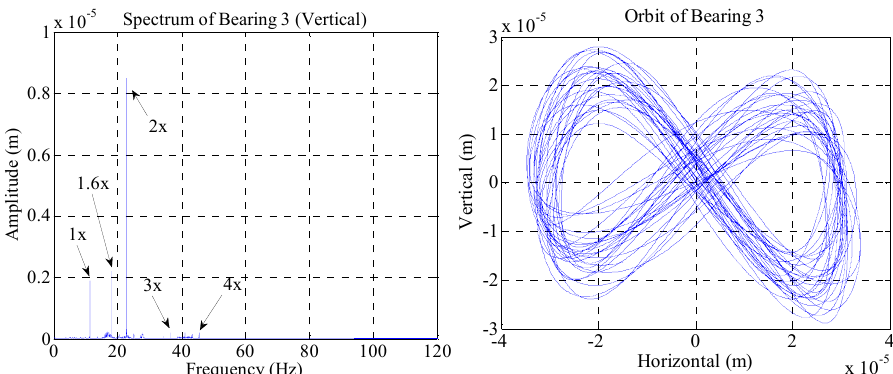
Figure 20. The spectrum and the orbit of Bearing 3.